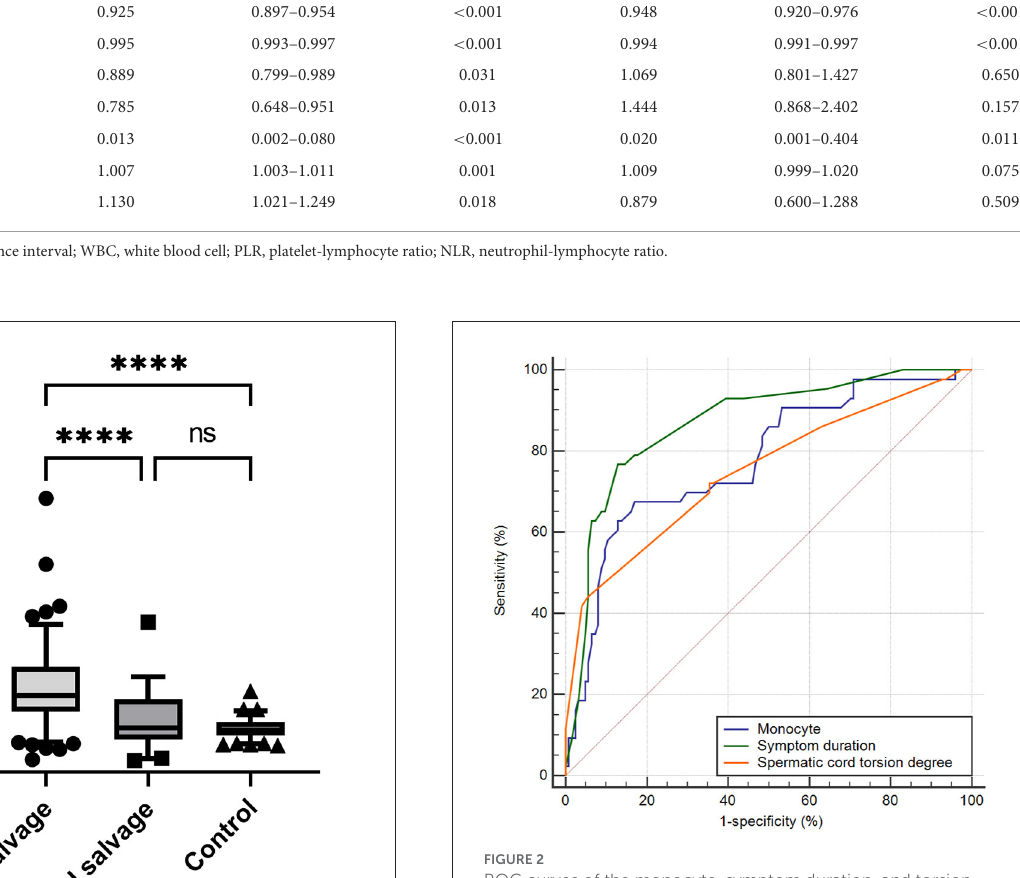
cut-off of 12 h) (Figure 2). A pairwise comparison of the ROC curve showed that symptom duration and torsion degree were statistically significant ( P = 0.032).